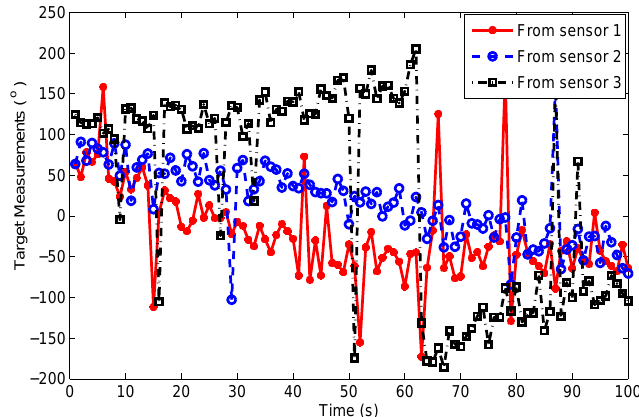
Figure 7. The target measurements from three sonobuoy sensors in Scenario 2.